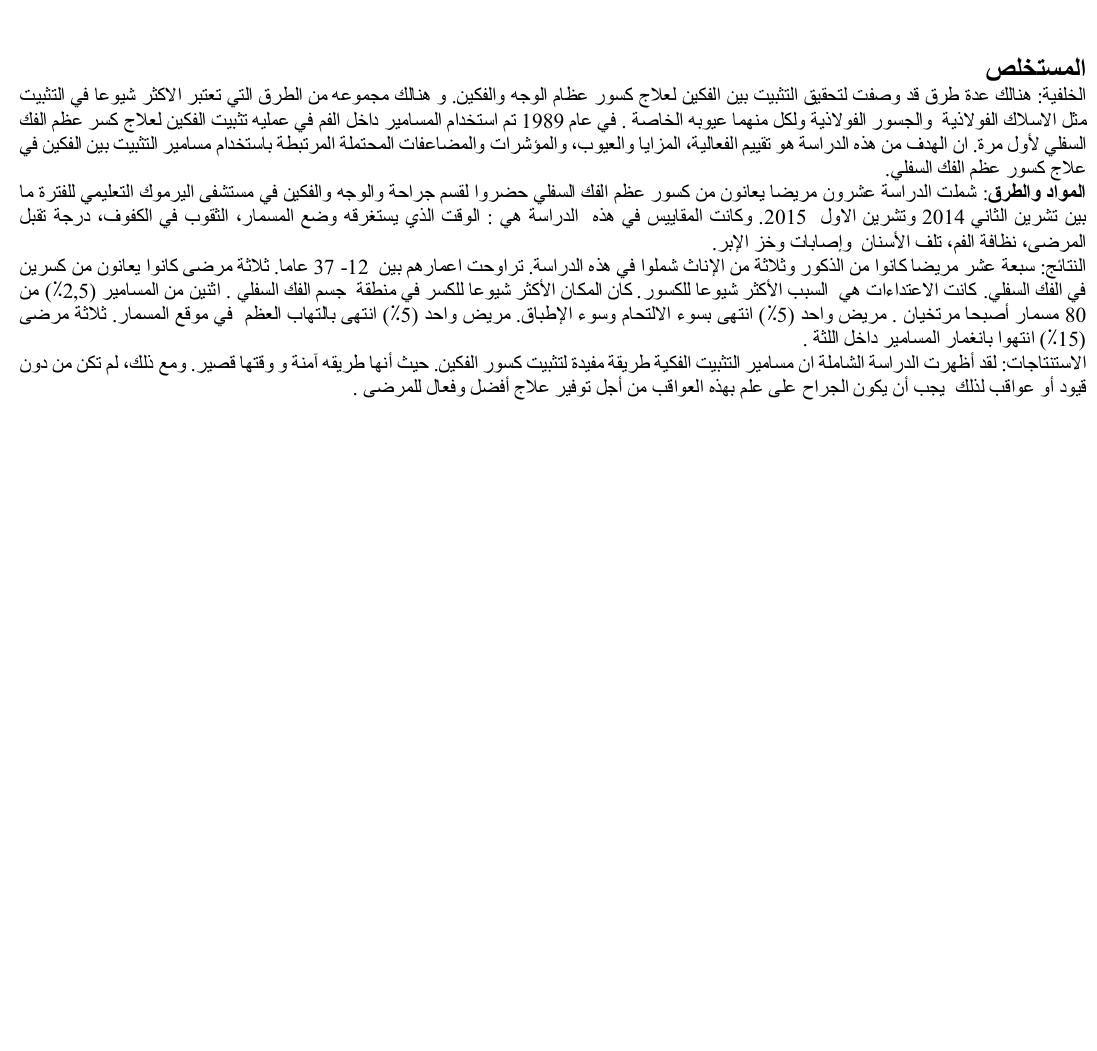
Oral and maxillofacial Surgery and Periodontics